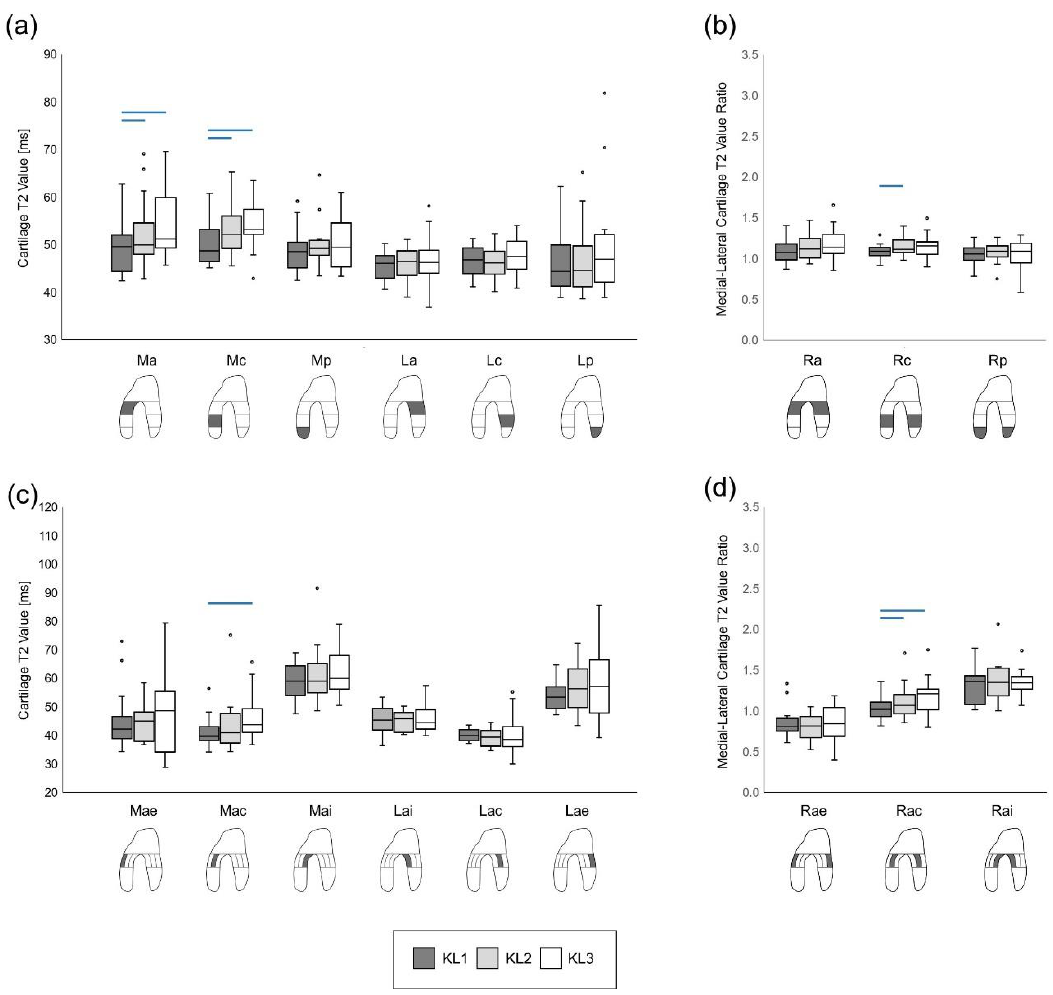
Figure B2. Box and whisker plots of deep cartilage T2 values per VOI ( a ) and sub-VOI ( c ) and their respective medial-lateral ratios ( b , d ). Horizontal bars indicate statistically significant (p < 0.017) changes between severity timepoints (blue: ES > 0.5; green: ES > 0.8).